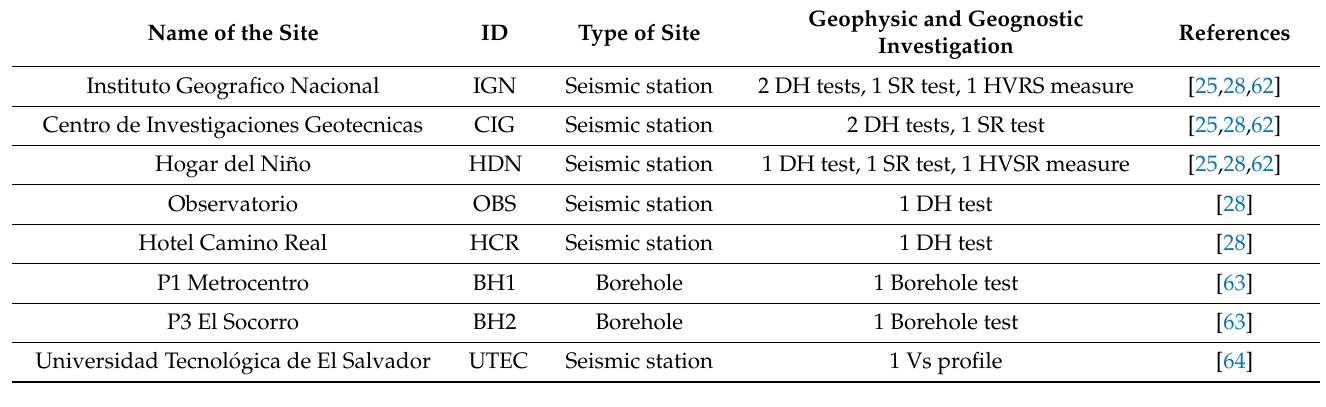
Table 4. Sites investigated for the reconstruction of two-dimensional subsoil models. DH: Down- Hole, SR: Seismic refraction, HVSR: Environmental Seismic Noise Measurements, BH: Borehole (see Figure 4).